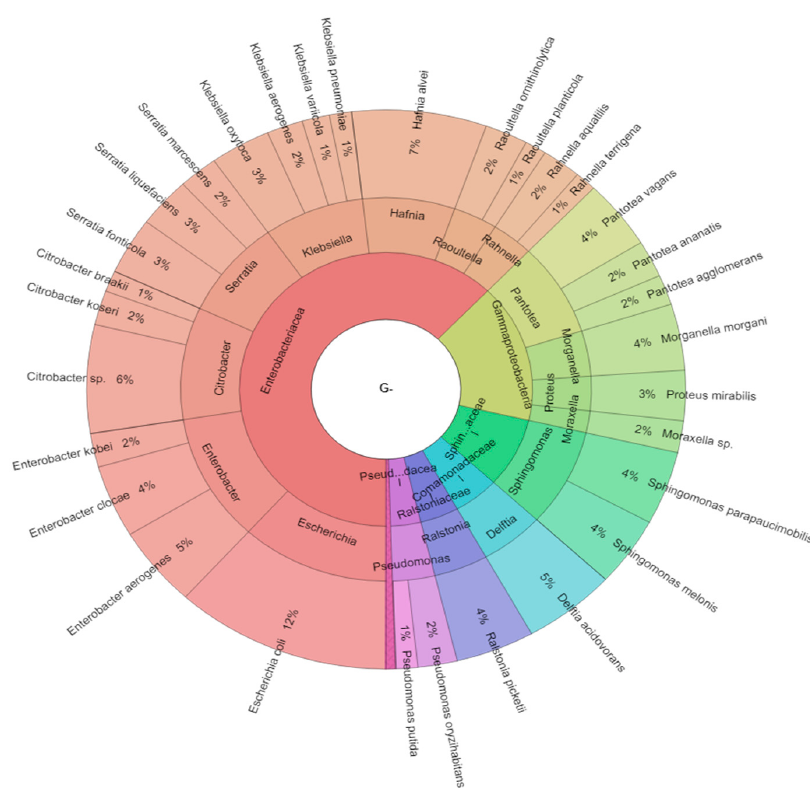
Figure 2. Krona RSF display of Gram-negative bacteriota isolated from bee digestive tracts. Presented are the frequencies of detected species, genera and classes, from the outer ring inwards.